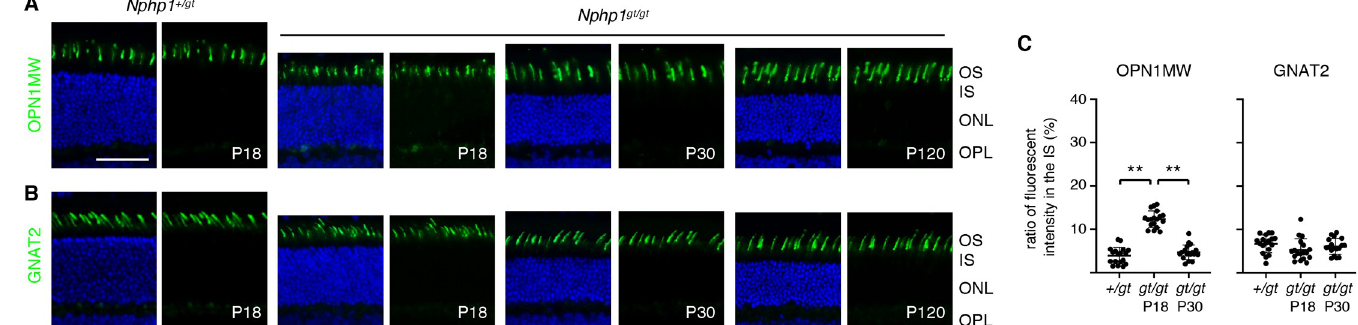
Fig 2. Localization of cone OS proteins in Nphp1 gt/gt retinas. (A-B) Cone OS proteins, OPN1MW (A) and GNAT2 (B), were immunostained in Nphp1 +/gt and Nphp1 gt/gt retinal sections. Mild mislocalization of OPN1MW was observed at P18 but not at P30 in Nphp1 gt/gt retinas. Scale bar denotes 50 μ m. (C) Quantification of cone OS protein mislocalization to the IS. Others are the same as in Fig 1E.